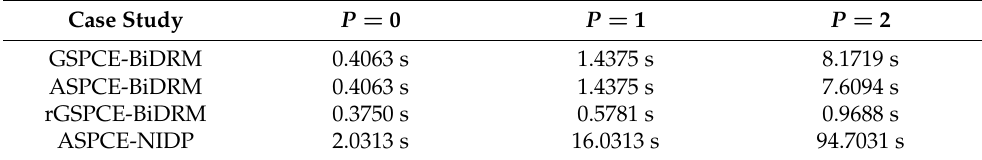
Table 4. Summary of the computational time to quantify uncertainty in model output in Example 1.